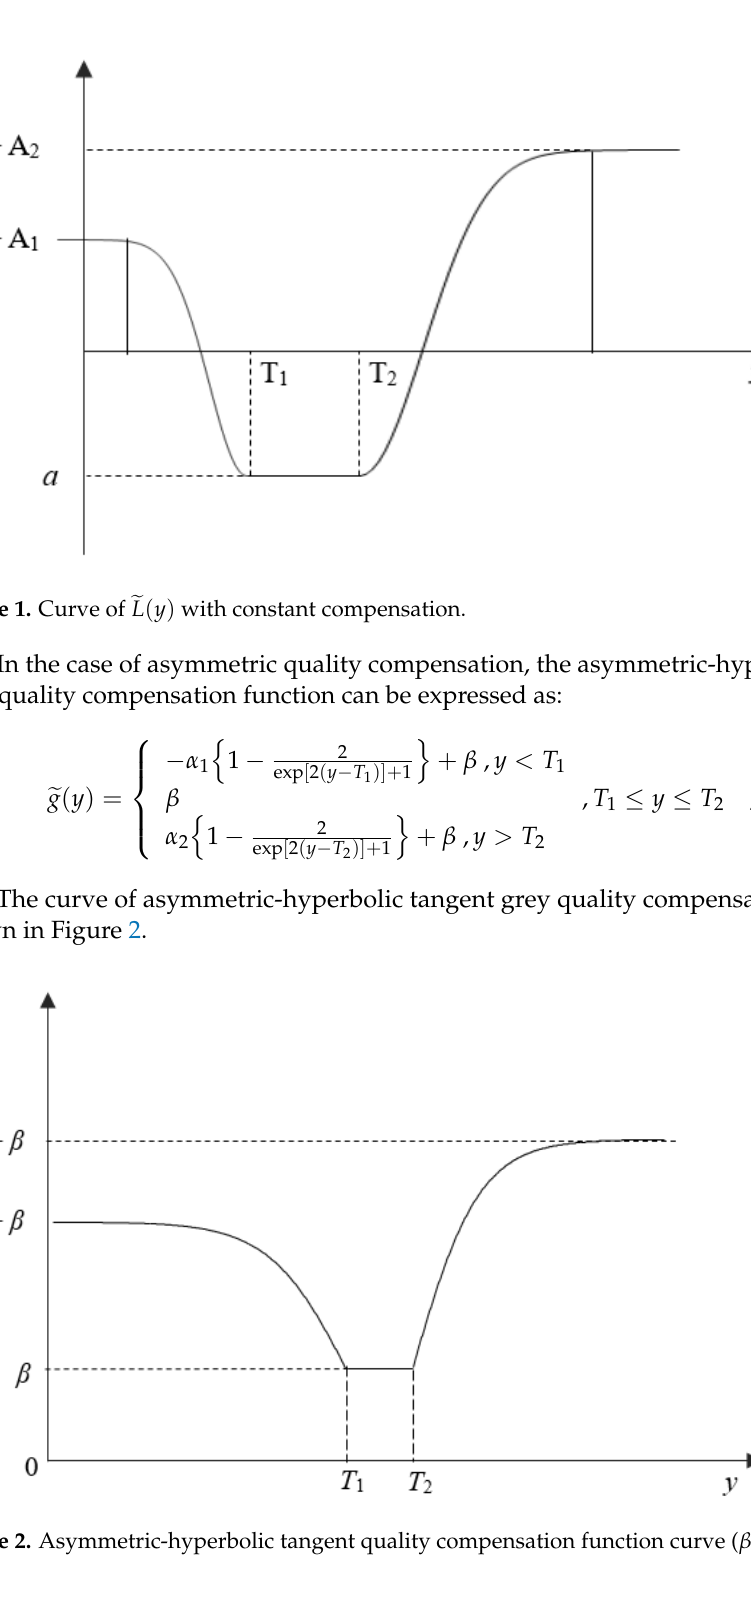
Figure 3. Grey quality gain–loss function curve of asymmetric-hyperbolic tangent compensation ( β > 0).